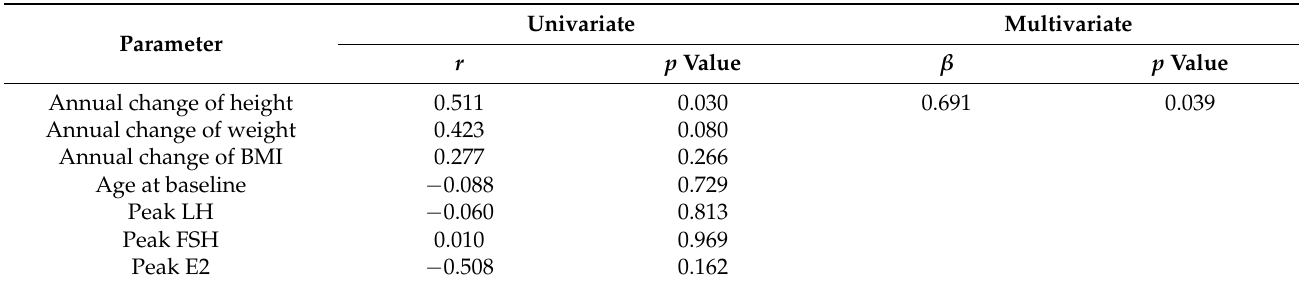
Table 3. Univariate and multivariate analysis of factors associated with annual change of axial length in girls treated